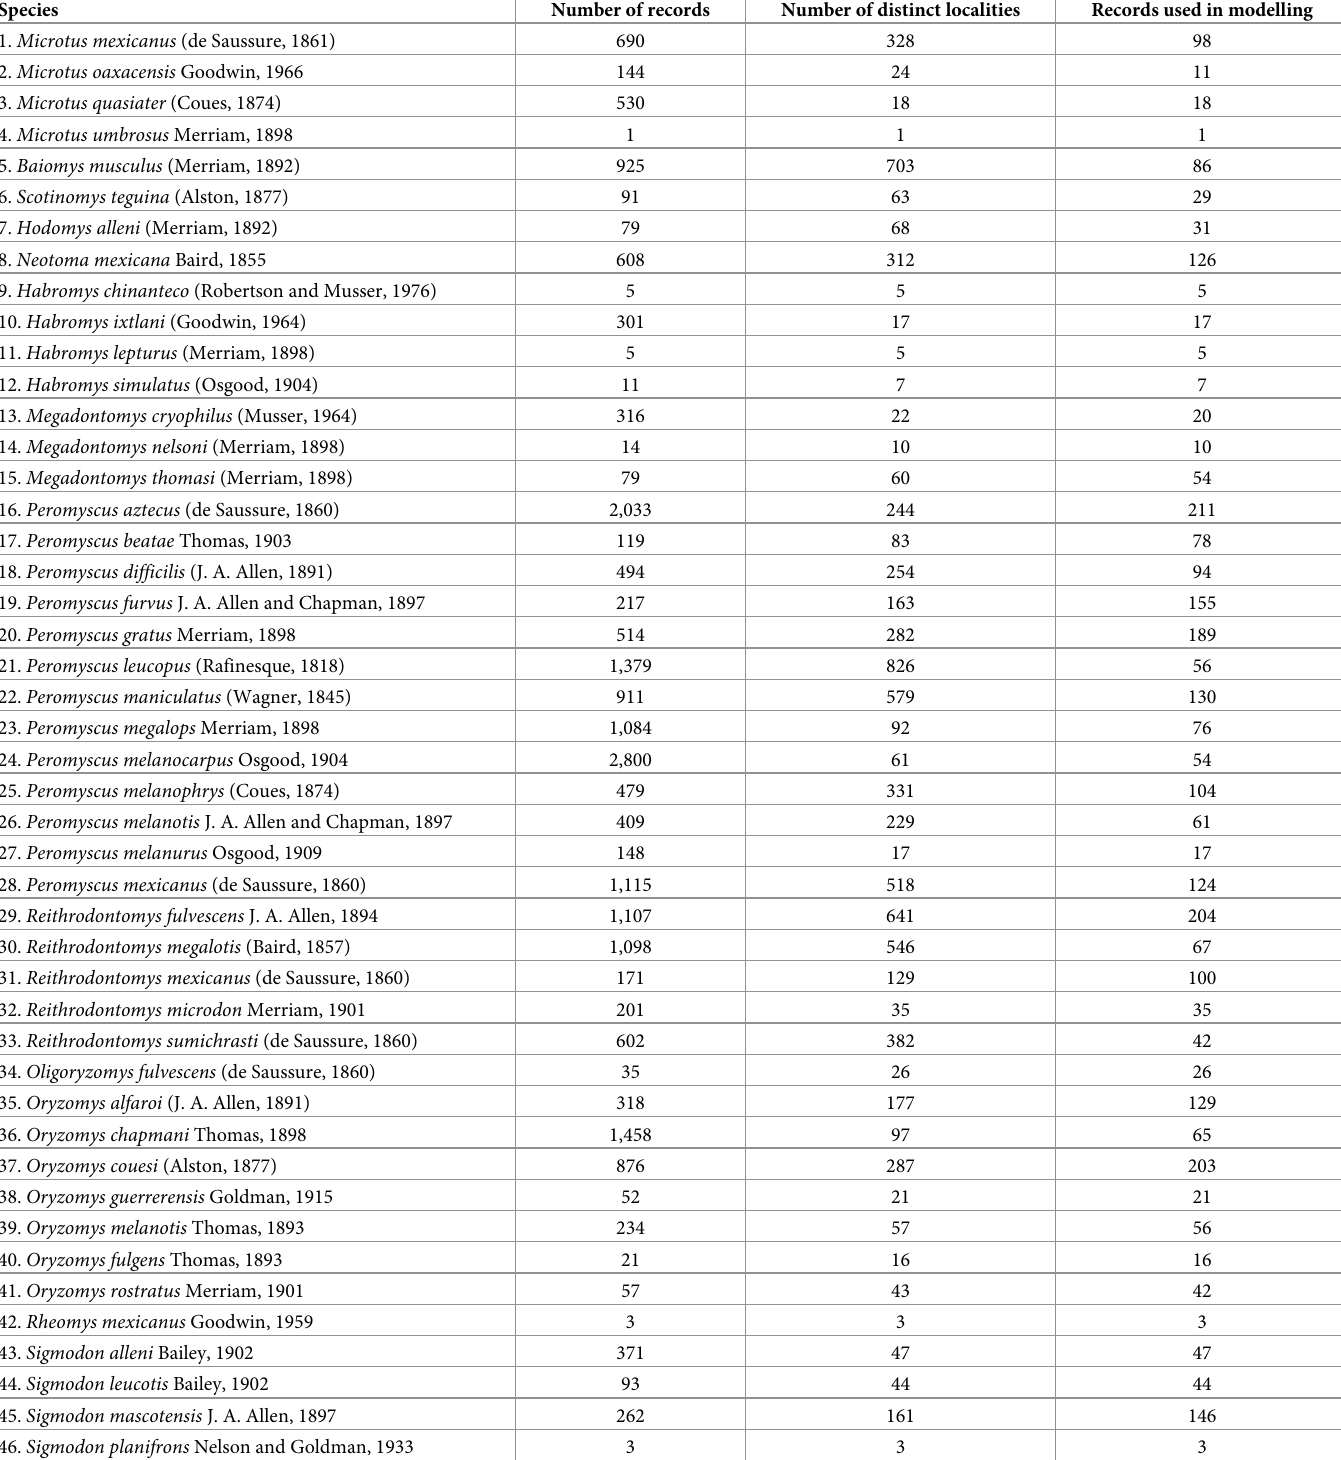
Table 3. Taxonomic list of cricetid species for the state of Oaxaca (following the nomenclature of Ramı´rez-Pulido [26]). The records were downloaded from the GBIF and provided by the OAXMA. The numbers of distinct localities are validated records.